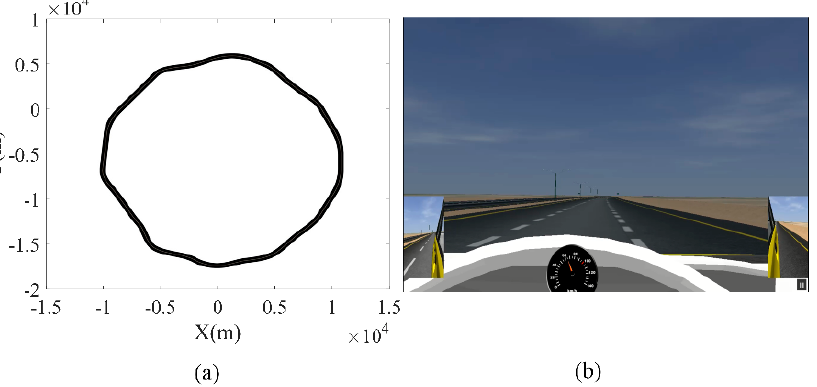
Figure 4. ( a ) Quasi-circular map of the three-lane highway with an average radius of 10 km; ( b ) graphical view of the road.